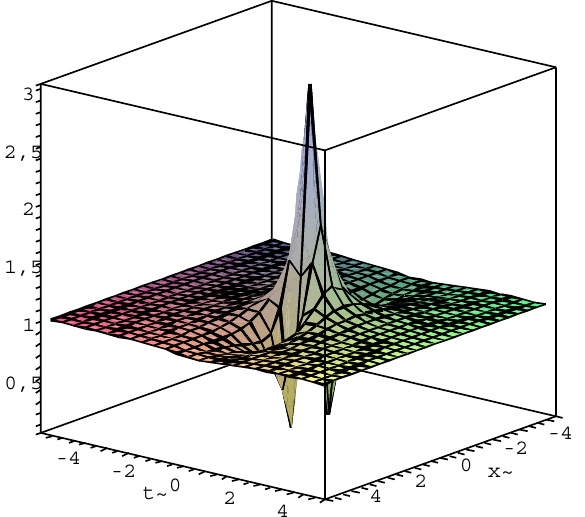
Fig. 1. Plot of | v(x,t) | for n = 1, ϕ 1 = 0 and ϕ 2 = 0.